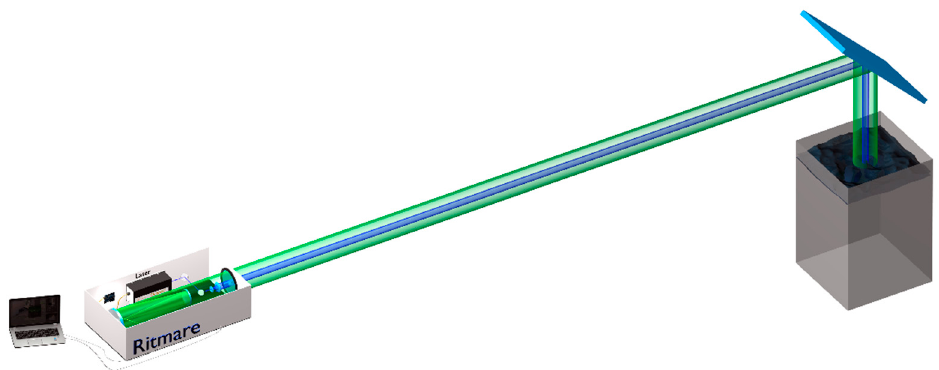
Figure 5. Experimental setup: the target has been located 15 m far from the LIDAR system, considering the telescope focusing setup (described in Section 2.1).